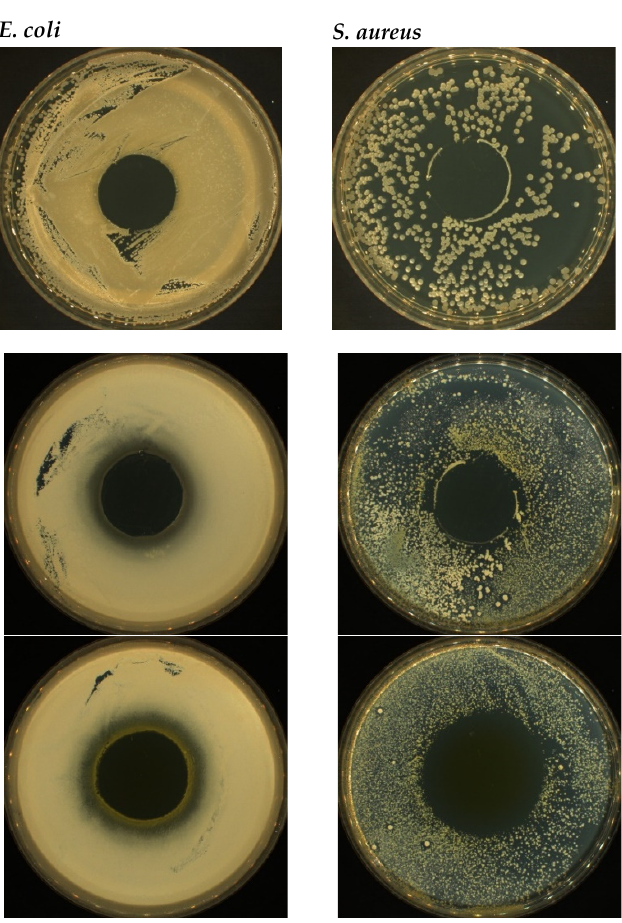
Figure 8. Photos of Bacteria ( E. coli and S. aureus ) cultures after contact with the studied polymeric films containing different amounts of berberine.